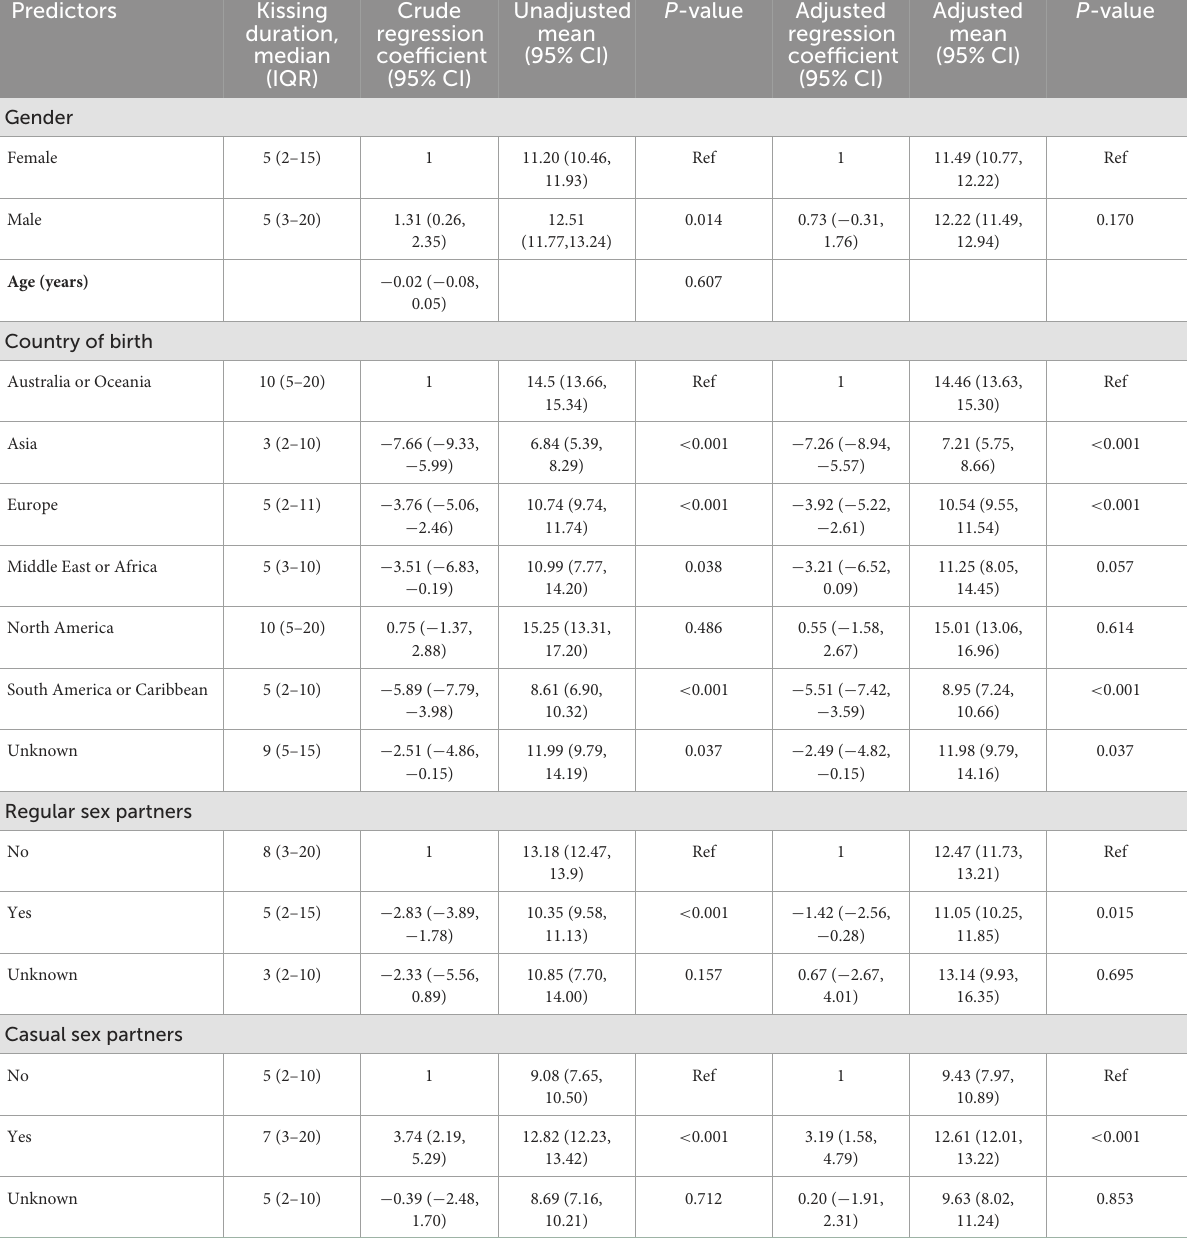
TABLE 2 Univariable and multivariable linear regression analyses of the association between demographic factors and the duration of kissing among 2,683 heterosexual men and women who had opposite-gender kissing partners in the past 3 months. Predictors Kissing